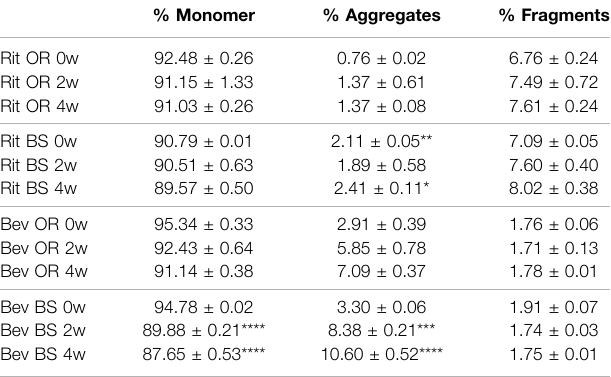
TABLE 1 | SEC data depicted as average % concentration contributions of monomer, aggregate, fragment peaks ( N = 3, mean ± SD). Aggregates and fragments include summations of multiple peaks, where applicable. Stressed samples were shaking at 240 RPM, incubating at 37 ° C for 2 or 4 weeks. All samples were diluted to 1.5 mg/ml to load 15 µg of antibody on the column.